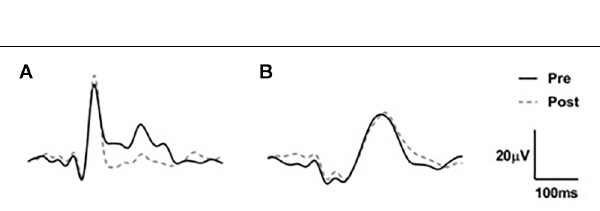
FIGURE 3 | Two examples of VEP waveforms (A) n older adult and (B) young adult averaged across channels demonstrating the individual variation between participant